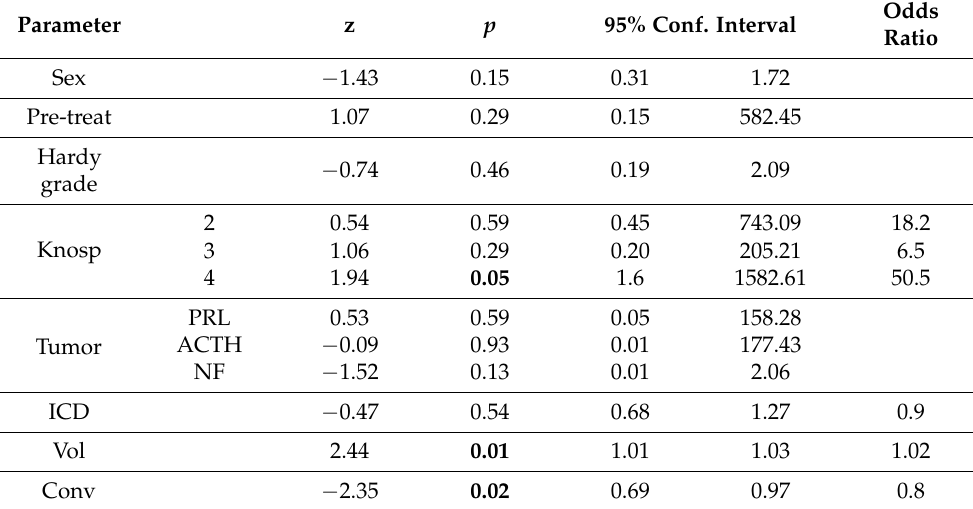
Table 4. Results of logistic regression. The three factors that were independently significantly associated with the extent of tumor resection were Knosp grade, the tumor volume (Vol), and the tumor convexity (Conv). The other potential predictors (Age, Wilson grade, Horizontal Diameter, Sphericity, Area, Zurich Score) were not statistically significant in univariate analysis and they were not included in the final model. For Knosp grade, Odds Ratios referred to Knosp grade 1 (ICD: inter- carotid distance, Vol: volume, Conv: convexity, Pre-Treat: previous treatment, Conf.: confidence). The bold data indicating a statistically significant